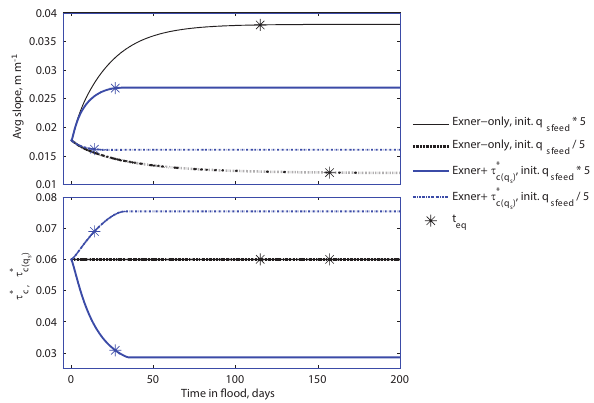
Figure 7. Slope and critical shear stress evolution, for sediment supply increases (which correspond to Fig. 6 models) and decreases by factors of 5. As in Fig. 6, t = 0 corresponds to an equilibrium condition where the initial slope and initial threshold are consistent with the initial upstream sediment supply. Slope and τ ∗ averaged over nodes 3–10, leaving out the first and last two nodes because of minor model boundary effects.